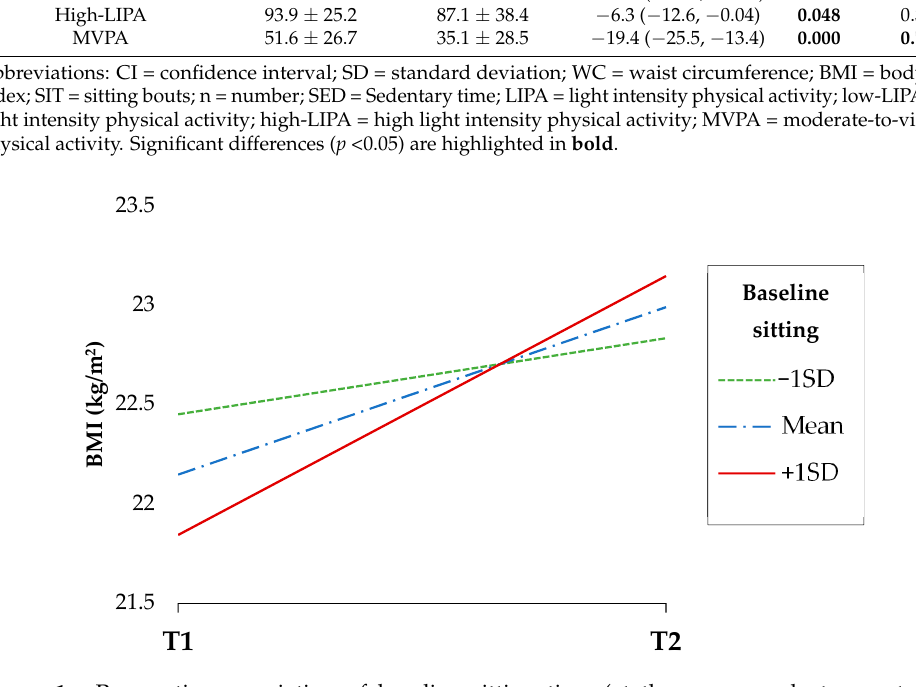
Figure 1. Prospective association of baseline sitting time (at the mean, and at one standard deviation below and above mean) on BMI. T1: Baseline; T2; follow-up; SD: standard deviation; BMI = body mass